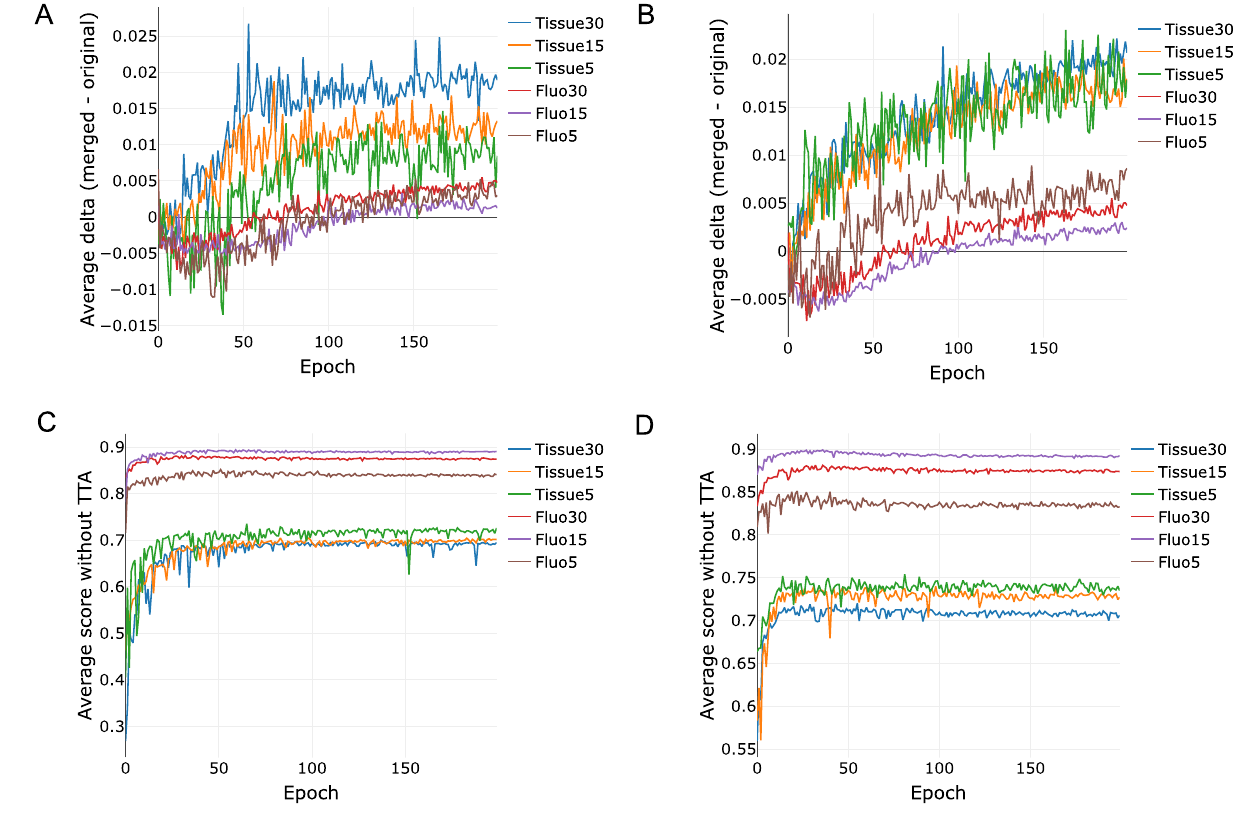
Figure 1. A correct version of the original Figure